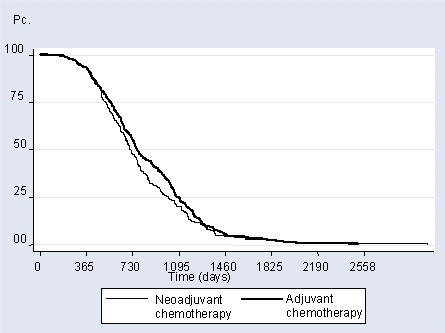
Overall survival for patients with stage III and IV ovarian cancer in the neoadjuvant chemotherapy and adjuvant chemotherapy groups.